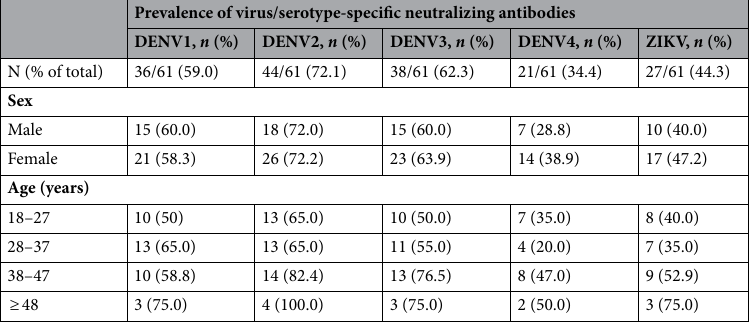
Table 2. Characteristics of participants according to DENV/ZIKV-neutralizing antibody status. Positive sera were defined as a 90% neutralizing titer >